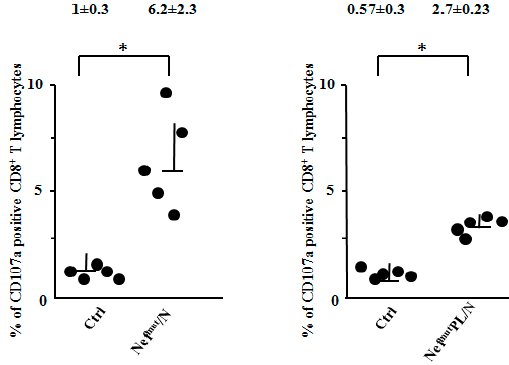
Figure 4. CTL activity as revealed in terms of CD107a expression in CD8 + T lymphocytes co- cultivated with DCs challenged with engineered EVs. CD107a FACS analysis on HLA-A.02 PBLs recovered after cross-priming with DCs challenged with EVs isolated from supernatant of cells transfected with pVAX1 (Ctrl), Nef mut /N, Nef mut PL/N. PBLs were analyzed 5 h after co-culture with HLA-A.02 MCF-7 cells pre-treated with either the unrelated or the SARS-CoV-2-specific peptide. The results in panel ( A ) are representative of five independent experiments carried out with cells from different HLA-A.02 healthy donors. Full data (1:1 cell ratio) are plotted in panel ( B ). Gating strategy (Supplementary Figure S3): co-cultures labeled with both FITC-conjugated anti-CD3 and APCCy7-conjugated anti-CD8 mAbs were selected for CD3 expression (for PBL identification), and then the CD8 + cell sub-populations were identified within CD3 + cells. Quadrants were set based on the fluorescence detected after cell labeling with relevant IgG isotypes. * p <